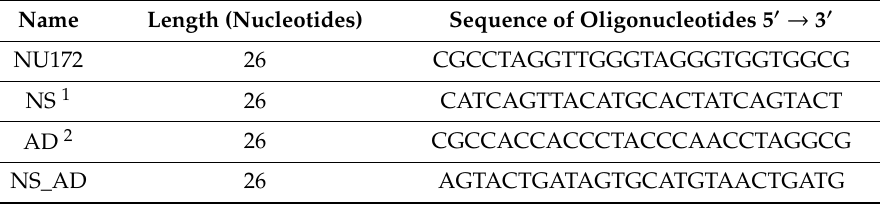
Table 1. List of used